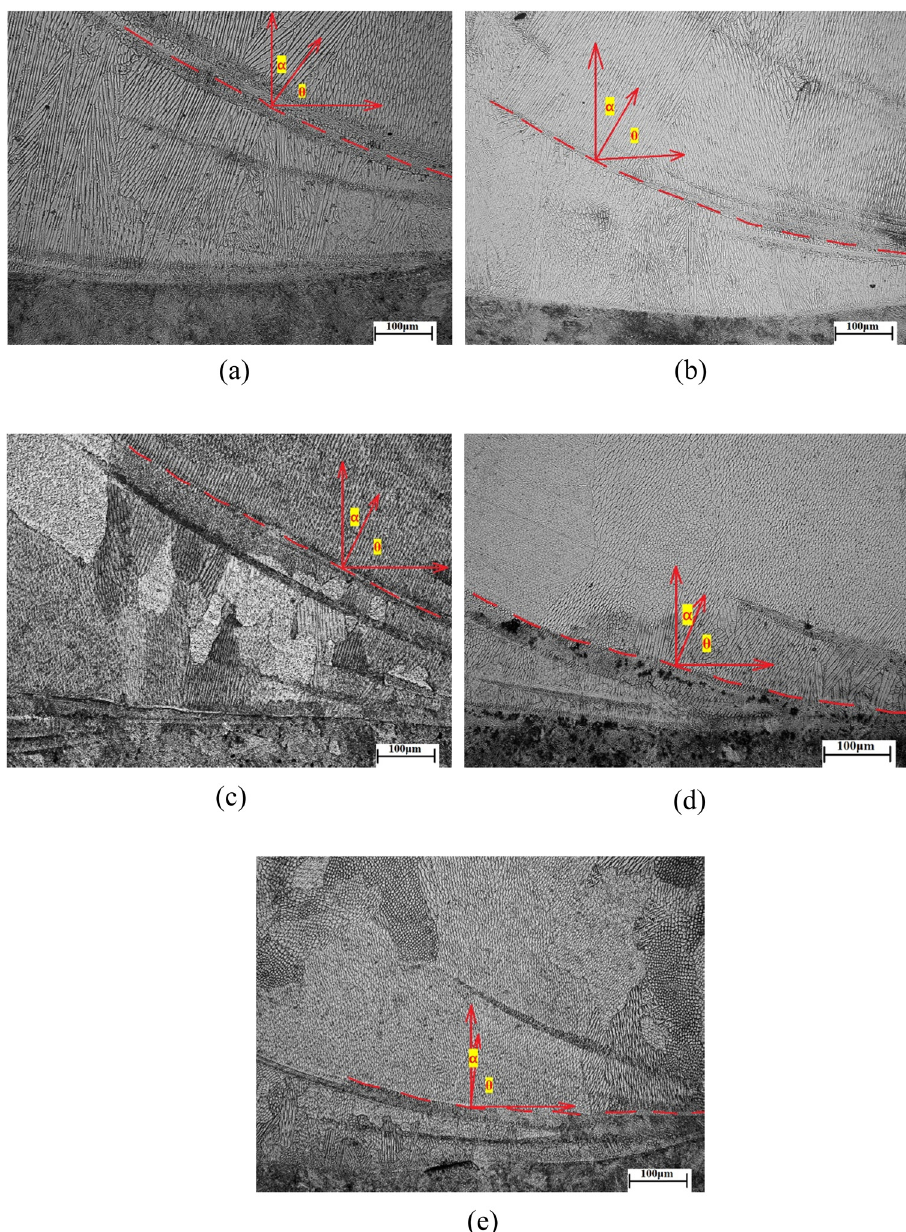
Figure 9: Microstructure of single - pass cladding layer at observation surface #2 obtained at di ff erent scan speeds V s : ( a ) 4 mm · s − 1 ; ( b ) 7 mm · s − 1 ; ( c ) 10 mm · s − 1 ; ( d ) 13 mm · s − 1 ; and ( e ) 16 mm · s − 1